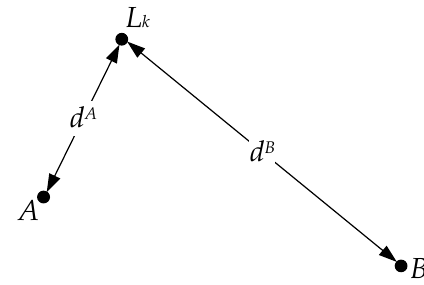
Figure 3. Key locations in the simulated scene. A and B represent the two capture positions of the viewer, L k is the k th landmark, and d A and d B separately denote the distance from L k to A and B .